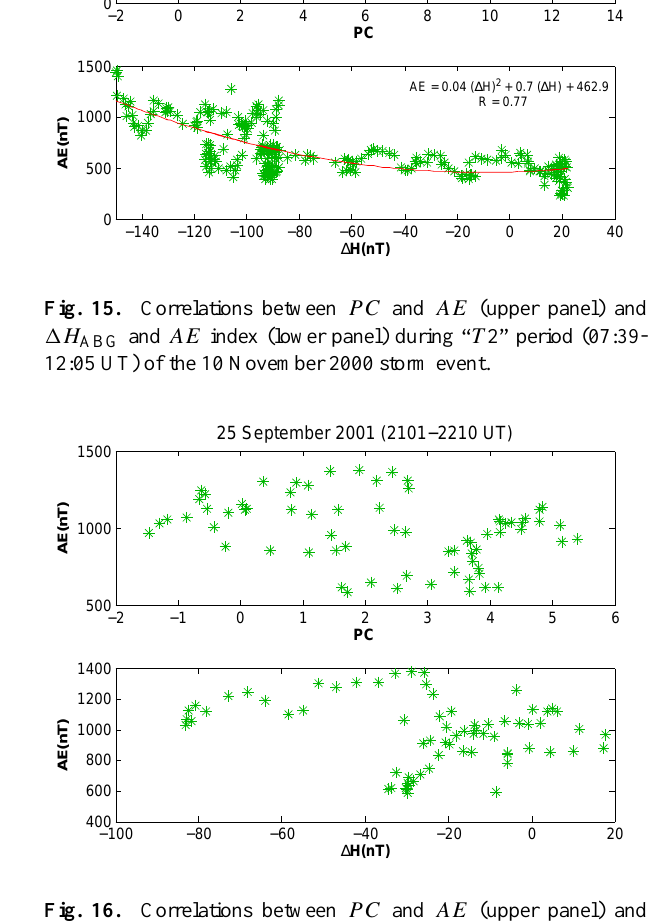
Fig. 16. Correlations between PC and AE (upper panel) and 1H ABG and AE index (lower panel) during “ T 2” period (21:01- 22:10 UT) of the 25 September 2001 storm